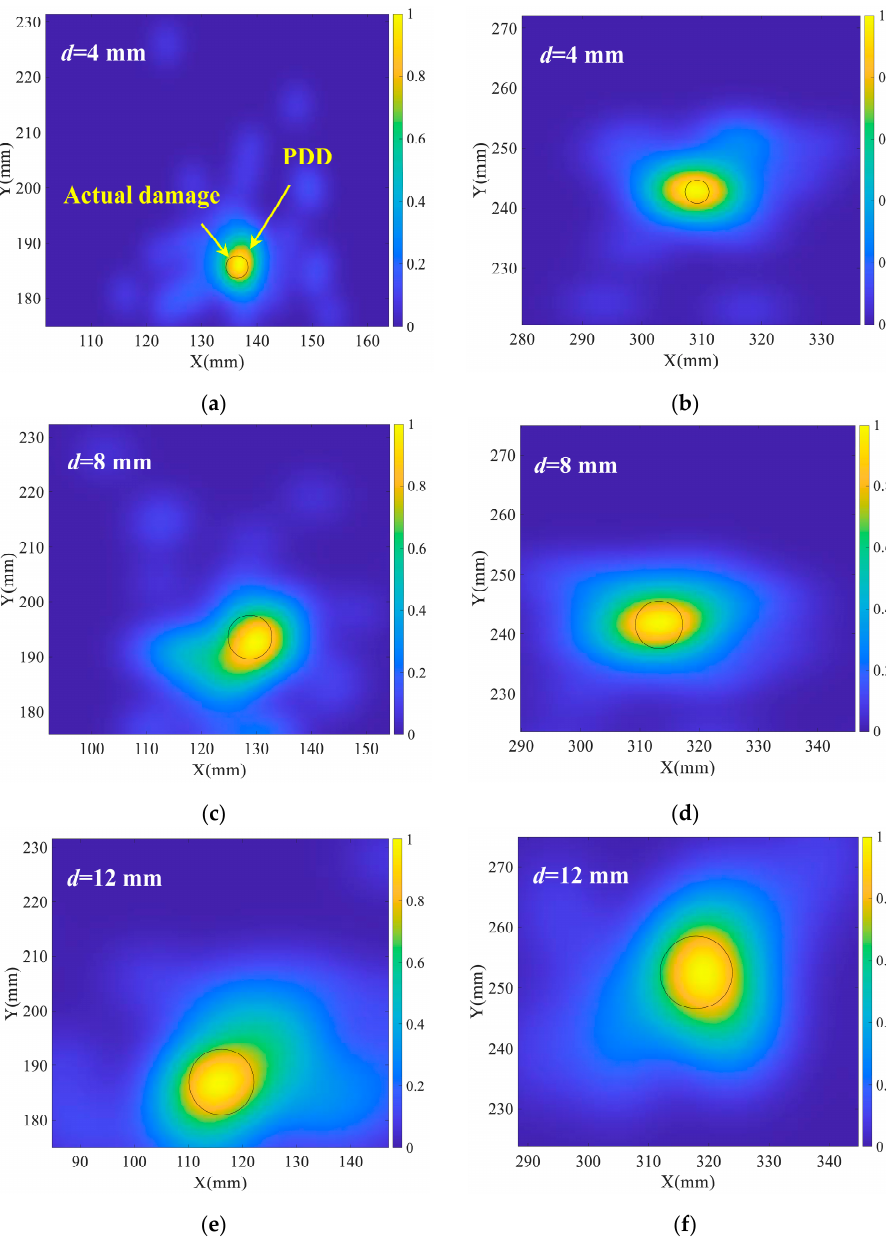
Figure 12. Quantification results of damage size. ( a ) damage center (127, 185) and d = 4 mm; ( b ) damage center (320, 245) and d = 4 mm; ( c ) damage center (127, 185) and d = 8 mm; ( d ) damage center (320, 245) and d = 8 mm; ( e ) damage center (127, 185) and d = 12 mm; ( f ) damage center (320, 245) and d = 12 mm.